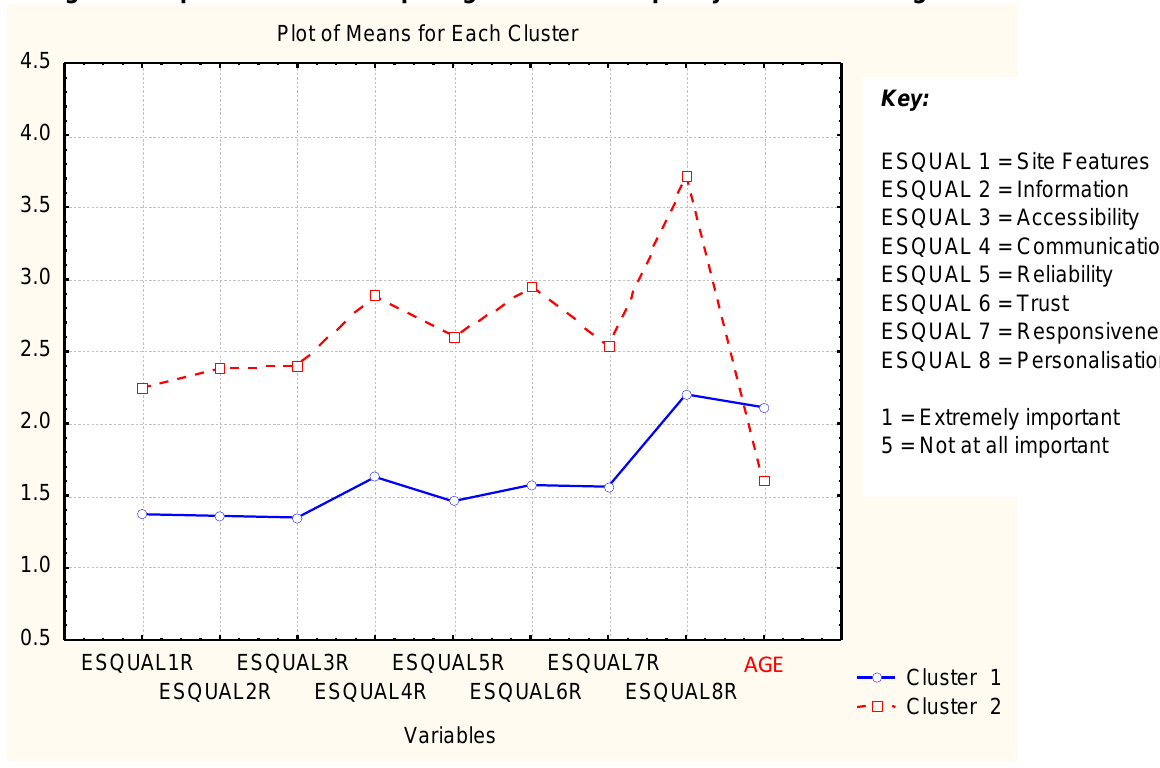
Figure 1: A plot of means comparing the e-service quality variables and age. Plot of Means for Each